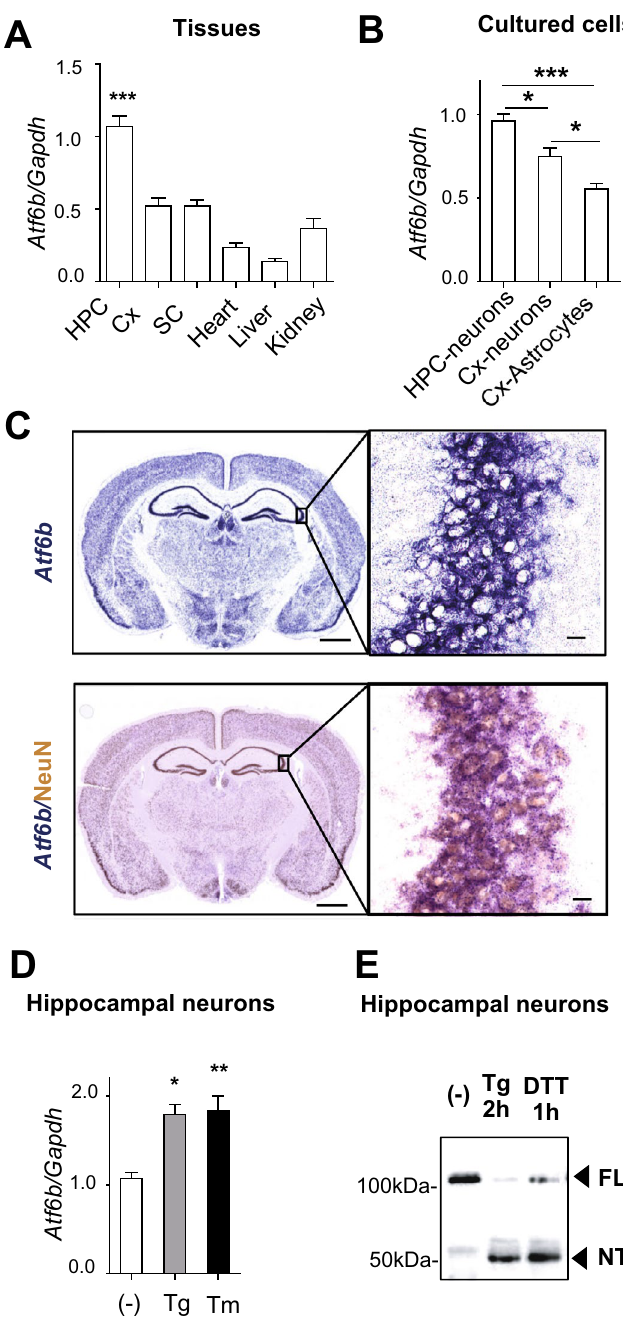
Figure 1. Expression and activity of ATF6β. ( A,B ) Expression of Atf6b mRNA in normal tissues (n = 5 mice) ( A ) and in cultured cells (n = 3–8) ( B ). HPC: hippocampus, Cx cerebral cortex, SC spinal cord. Total RNA was isolated from the indicated samples and qRT-PCR was performed. Data are shown as mean ± SEM. *p < 0.05, ***p < 0.001 by a one-way ANOVA followed by the Tukey test. ( C ) In situ hybridization (upper panel) and in situ hybridization-immunohistochemistry (lower panel) of Atf6b mRNA in the normal brain. Images in the right panels are enlarged views of the CA3 area. Scale bars: 200 μm (left panels) and 25 μm (right panels). Typical images from three independent experiments are shown. ( D ) qRT-PCR analysis of expression of Atf6b mRNA in primary hippocampal neurons under ER stress. Cells were treated with Tg (300 nM) or Tm (1 μg/ml) for 8 h and then qRT-PCR was performed. n = 3. Data are shown as mean ± SEM. *p < 0.05, **p < 0.01 by a one-way ANOVA followed by the Tukey test. ( E ) Activation of ATF6β by ER stress in primary hippocampal neurons. Cells were treated with Tg (300 nM) for 2 h or DTT for 1 h. Extracted proteins were subjected to western blotting. The typical data from two independent experiments are shown. FL full length, NTF N-terminal